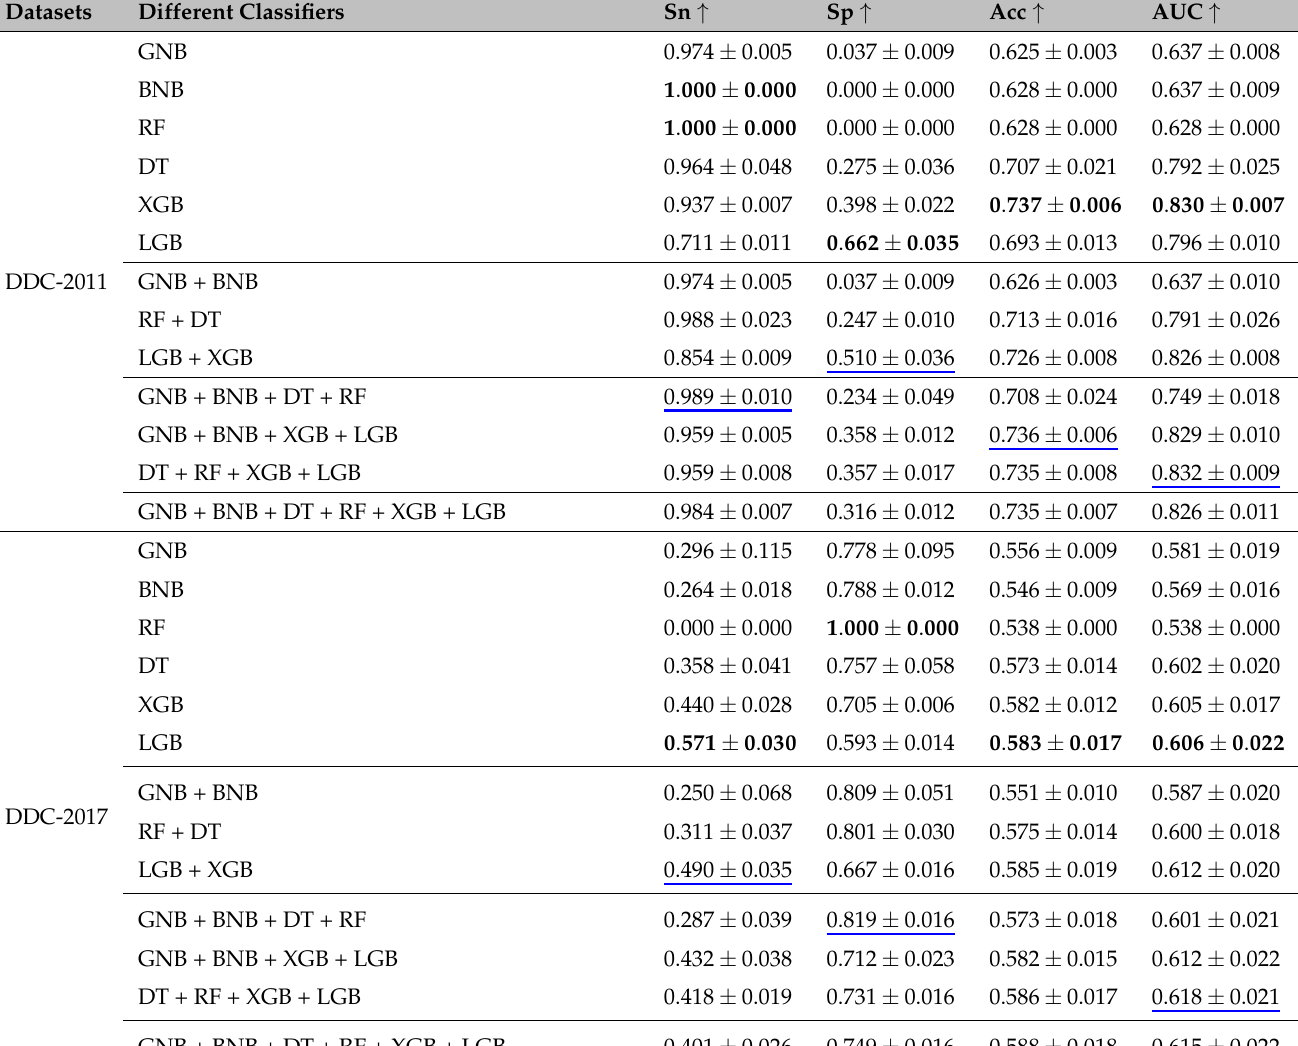
Table 7. Diabetes classification results have been obtained by implementing six individual ML and weighted ensemble models in the proposed DDC-2011 and DDC-2017 datasets, including the imputation of missing value, feature picking, and hyperparameter tuning. The metrics of the best- performing single model are highlighted in bold fonts, whereas the blue underlines are used to indicate them in the proposed ensemble